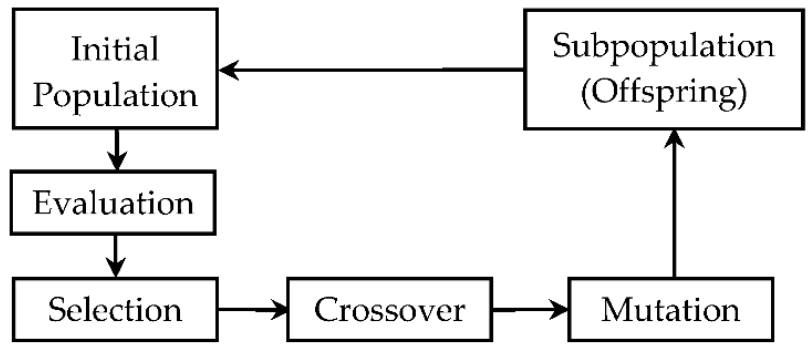
Figure 8. The genetic algorithm cycle block diagram.